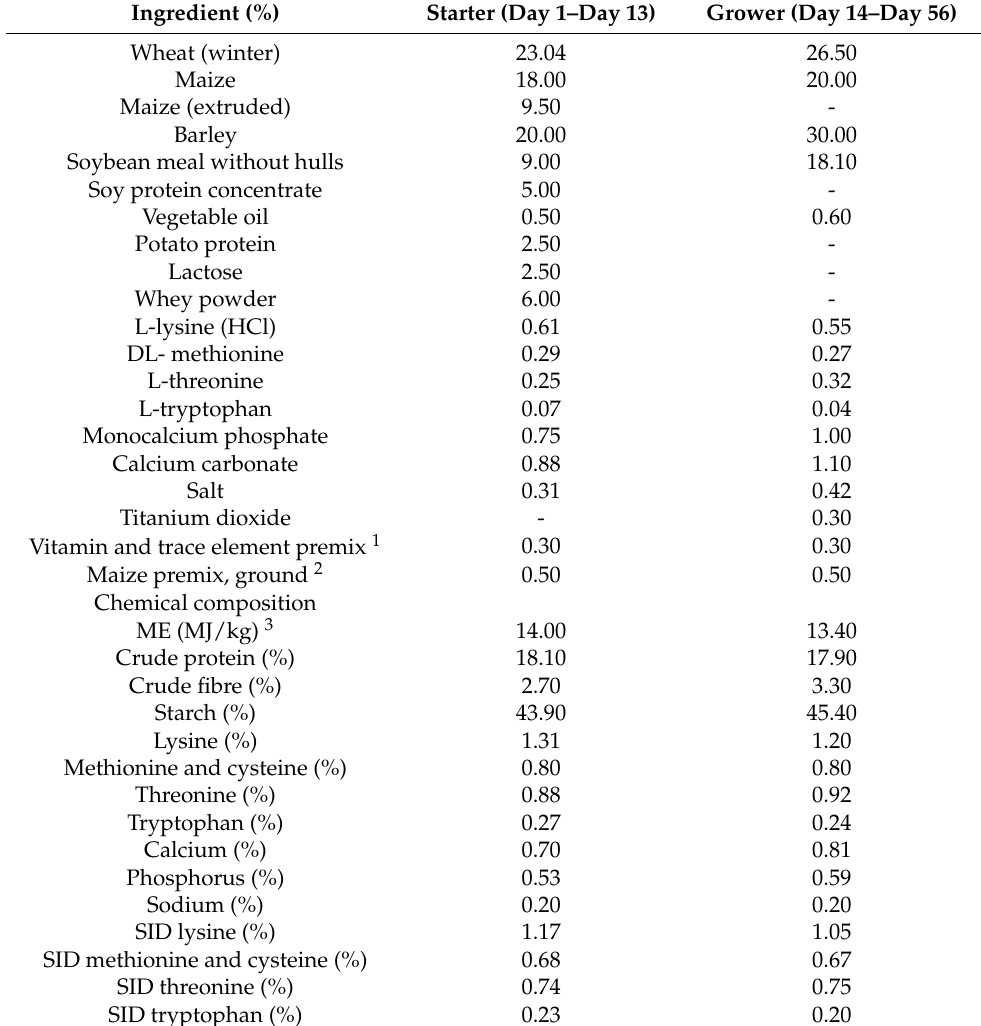
Table 1. Composition of the experimental diets (as-fed basis) in the starter and grower